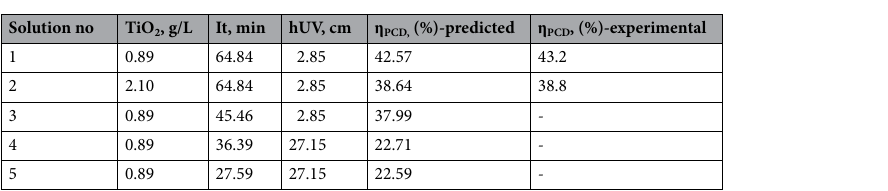
Figure 5. ( A ) Surface plot efficiency vs It and TiO 2 , at hUV = 15 cm; ( B ) Surface plot efficiency vs hUV and TiO 2 , at It = 37.5 min; ( C ) Surface plot efficiency vs It and hUV, at TiO 2 = 1.5 g/L.